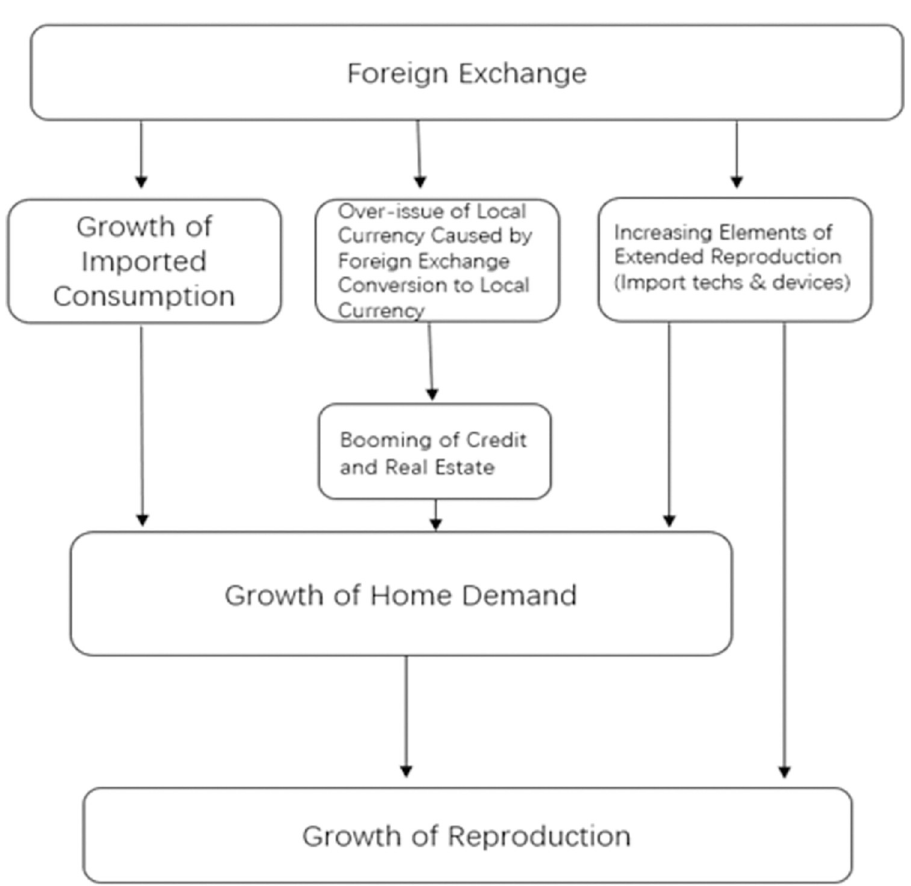
Fig 1. China’s foreign trade dividend logic with the fuel of foreign exchange in the 2000s. As shown in Fig 1, China’s massive inflow of foreign exchange has contributed to the expansion of the domestic market, the expansion of production factor inputs, and the prosperity of the financial and real estate